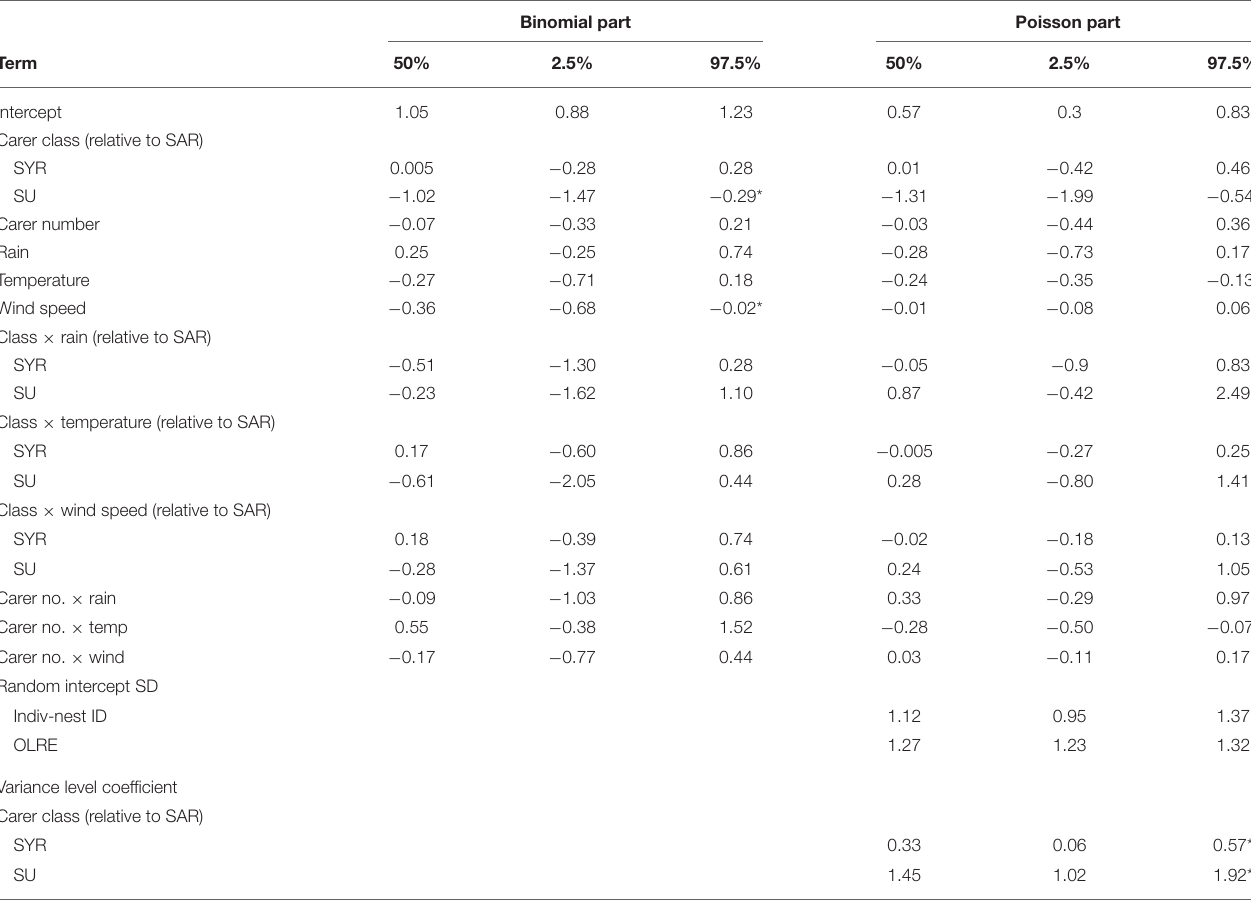
TABLE 2 | Phenological, meteorological, and social effects on the provisioning rate of helpers as a function of their age-relatedness class. Binomial